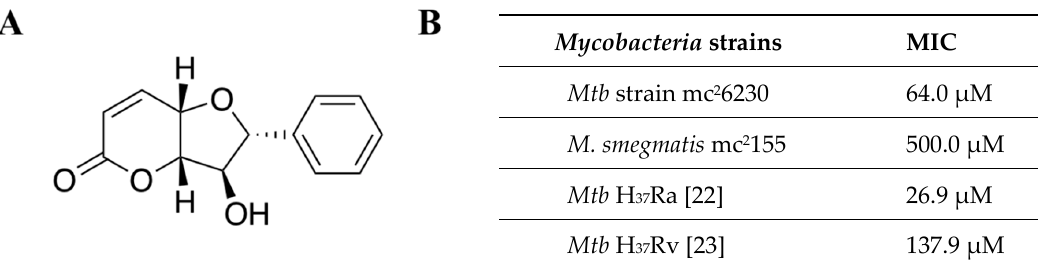
Figure 2. ( A ) Structure of altholactone; and ( B ) biological activity of altholactone against Mycobacteria strains and species. strains and